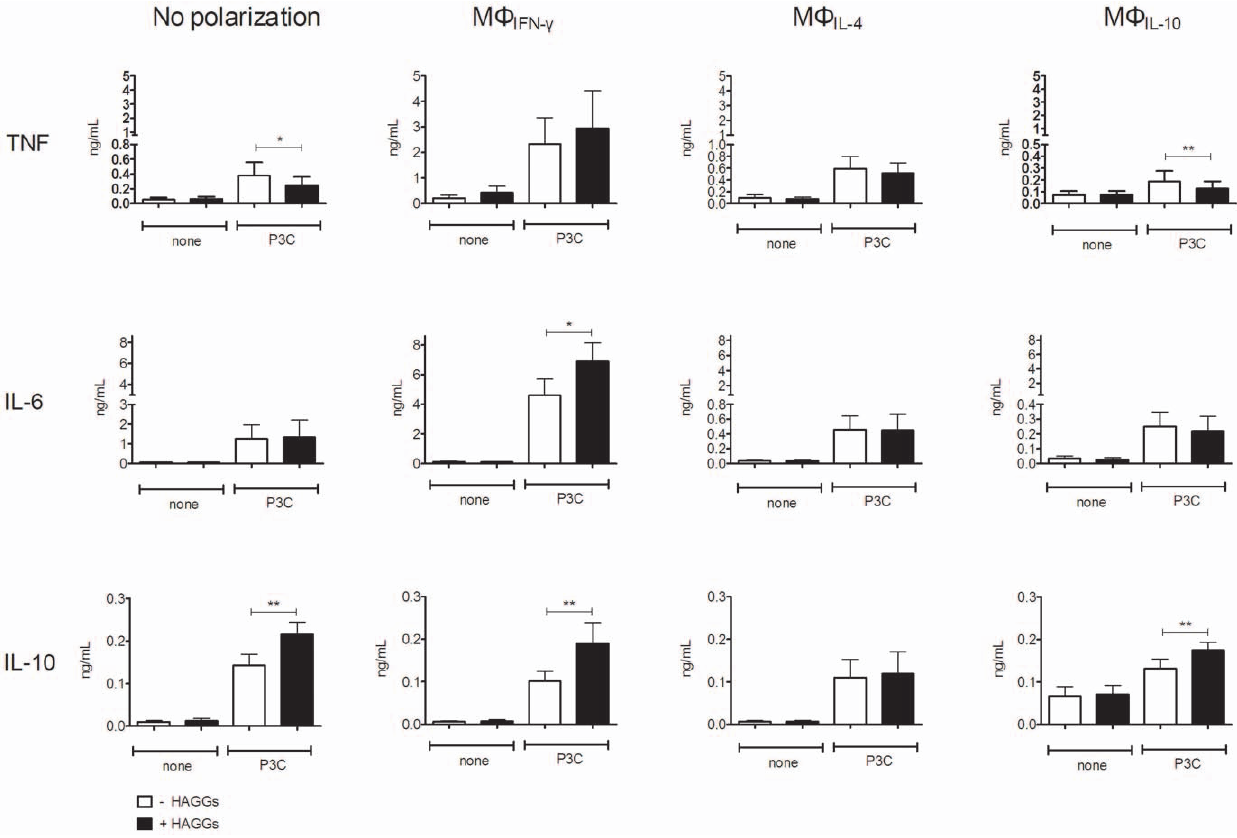
Figure 3. TNF, IL-6, and IL-10 production by M W IFN- c , M W IL-4 , and M W IL-10 after stimulation with HAGGs and P3C. Healthy peripheral blood monocytes were cultured for 4 days in medium or in medium supplemented with IFN- c , IL-4, or IL-10. Polarized macrophages were not stimulated, or stimulated for 20 hours with P3C, in the presence or absence of HAGGs. Bars represent the mean 6 SEM of 9 independent experiments. *p , 0.05, **p , 0.01.